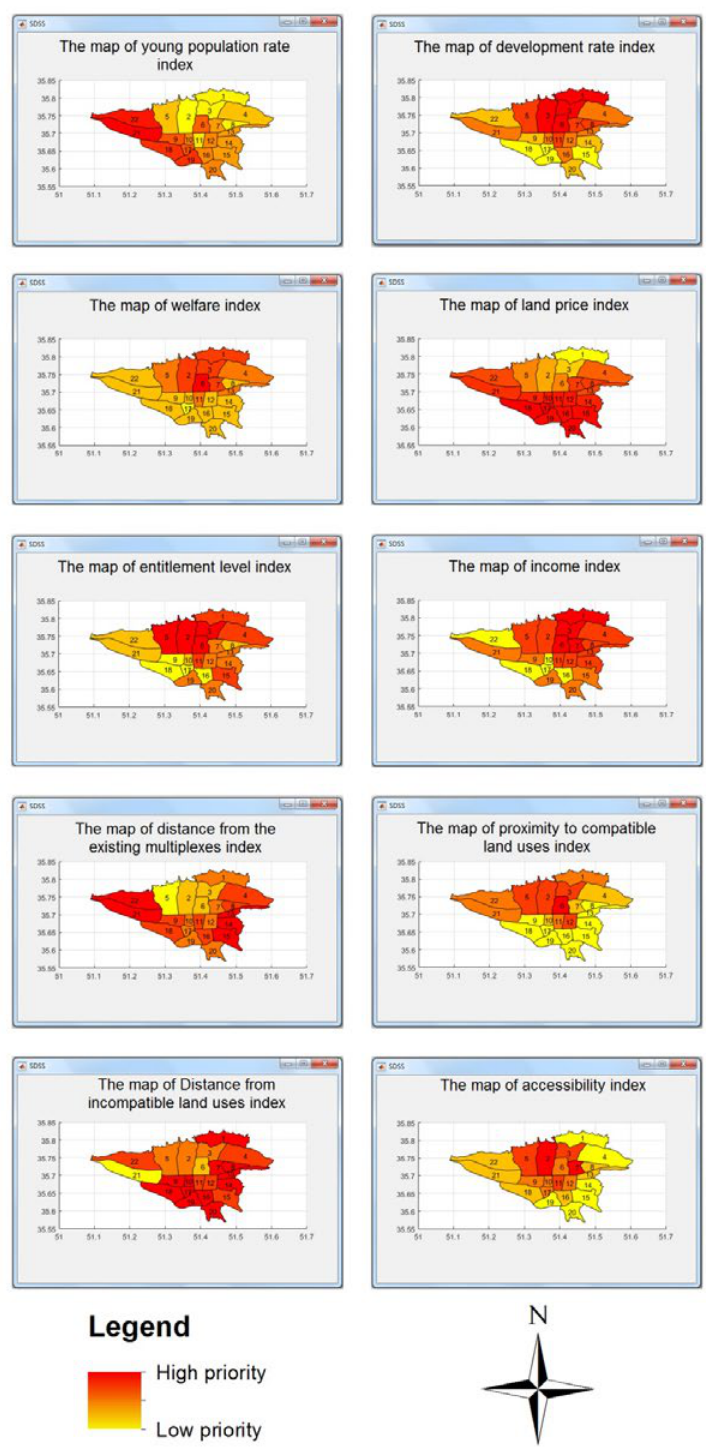
Fig. 7: The maps of prioritization based on different indices